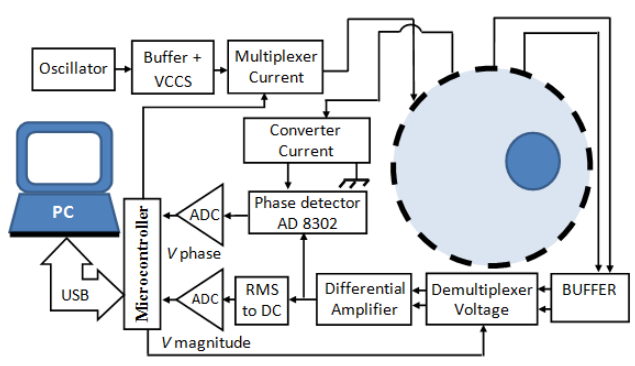
Figure 4. Block diagram of Electric Impedance Tomography System for real and imaginary functional images.